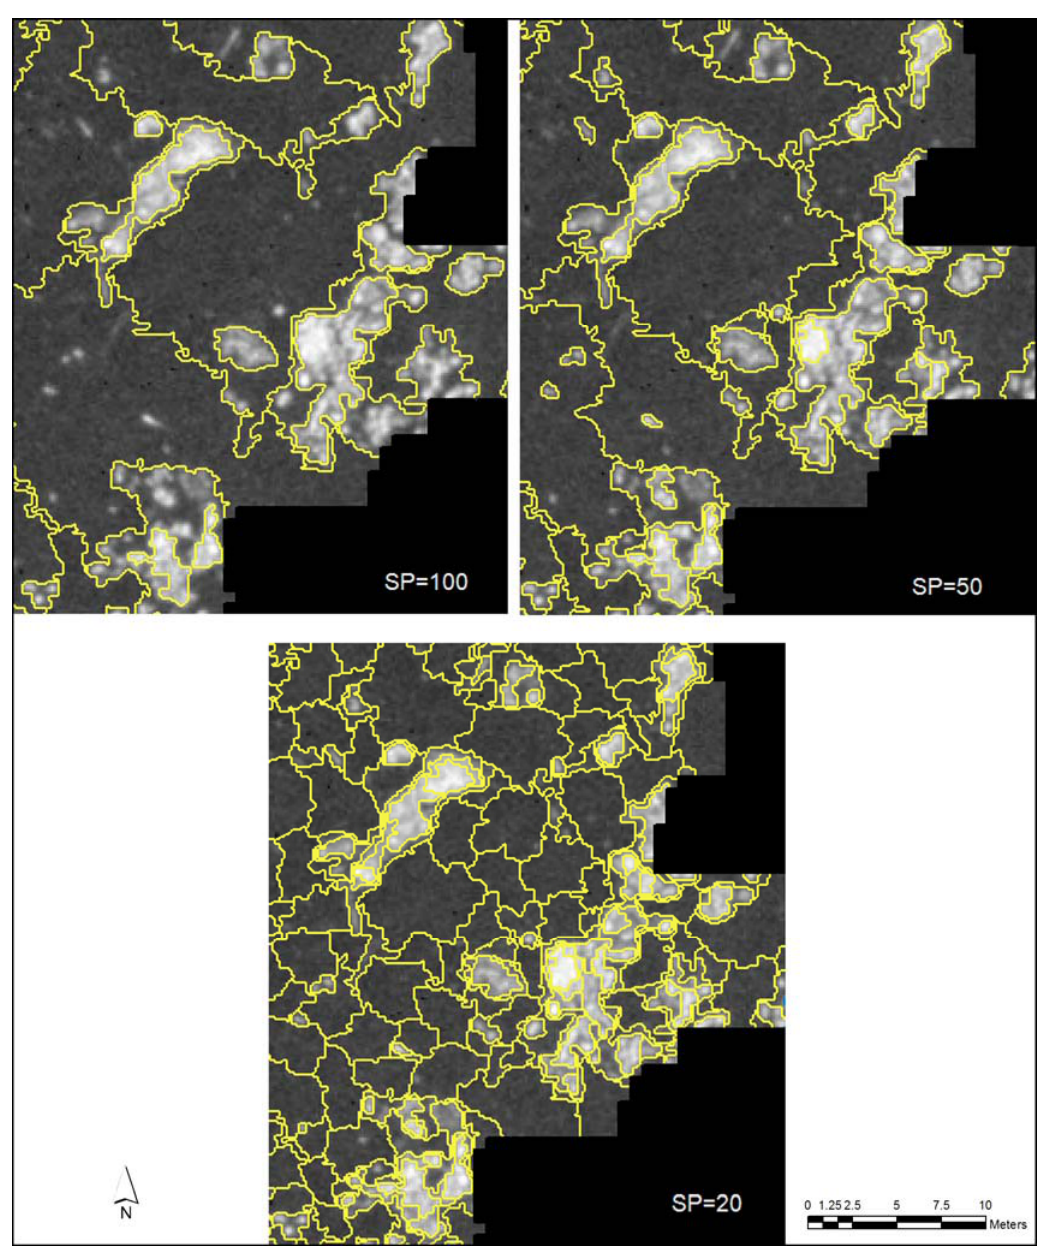
Figure 7. Example segmentation of a portion of a wetland in the red band to determine the optimal scale parameter value for the within wetland classes of log and wetland vegetation (both bright) versus water (dark). (SP = Scale